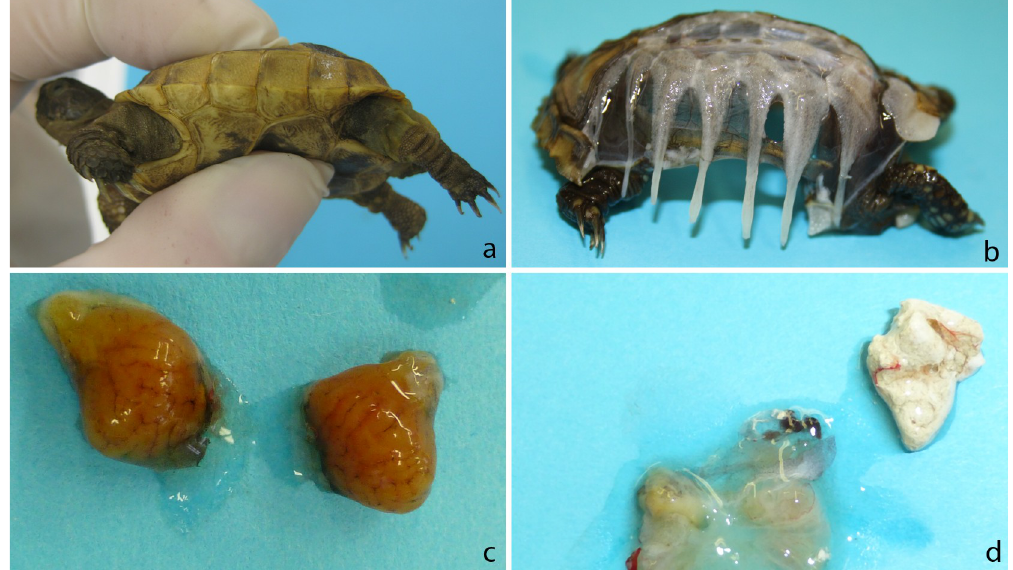
Fig 4. Gross pathological findings in the euthanised animals. a: soft carapace and plastron b: plastron with sieve like bone matter and lack of bridging between the ribs c: enlarged swollen kidneys d: urinary bladder emptied, with uric acid